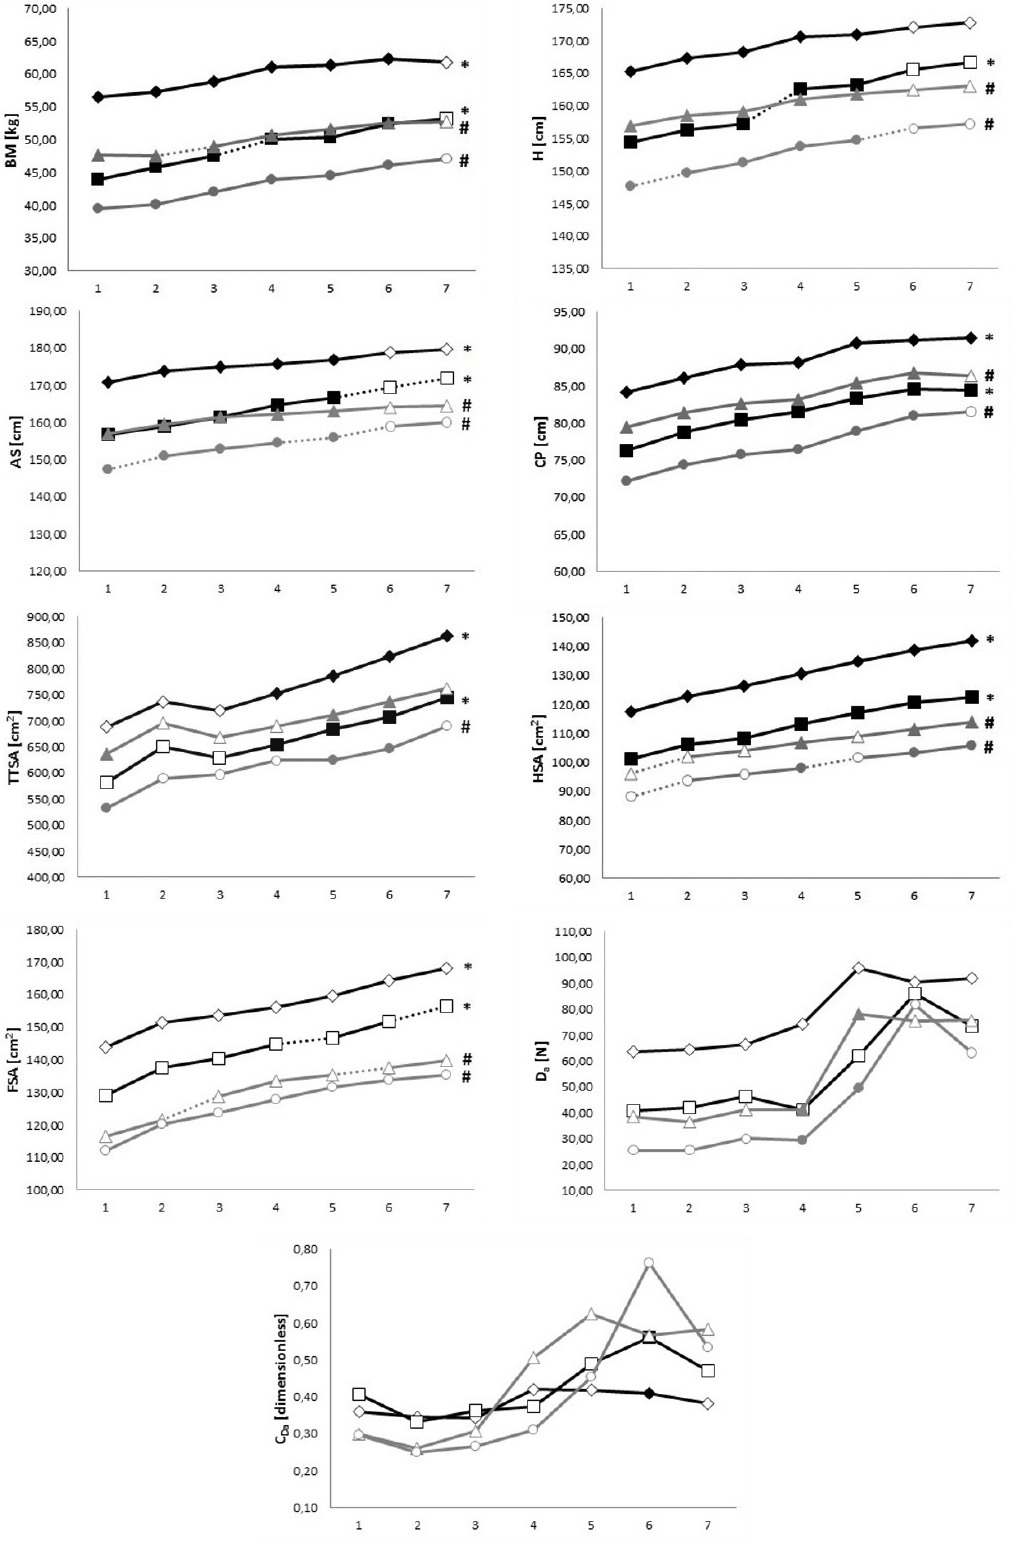
Figure 2. Anthropometric and hydrodynamic variability along the two seasons. Black solid line (♦) (■) – boys sports level 1 and 2 respectively; grey solid line (▲) (●) – girls sports level 1 and 2 respectively; dot parts within solid line means significant differences ( p ≤ .05) between moments for each sports level; white background in the marker – no-significant differences (P>0.05) between sports level within each gender; BM – body mass; AS – arm span; H – height; CP – chest perimeter; TTSA – trunk transverse surface area; HSA – hand surface area; FSA – foot surface area; D – active drag; C – active drag coefficient; * and # after each sports level line – significant differences ( p ≤ .05) between initial (1) and final a Da moment (7) for boys and girls,